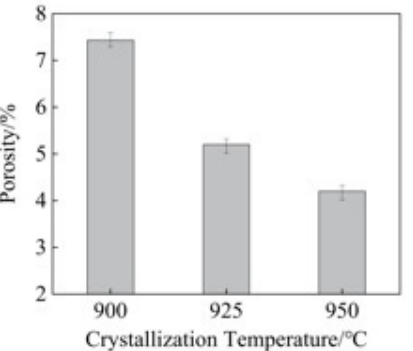
Figure 6. Effects of crystallization temperature on the water absorption of the microcrystalline glass.